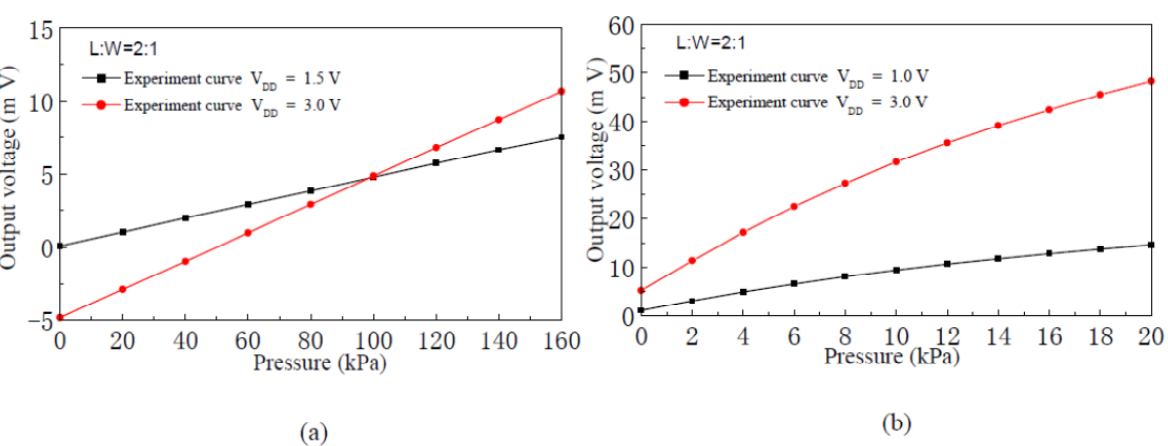
Figure 7. Input-output characteristics experimental curves of the nc-Si/c-Si heterojunction